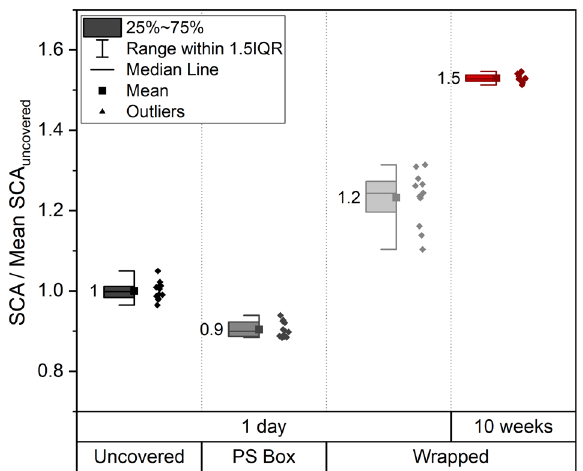
Figure 2. Contact angle of a 3 µl droplet on polished copper samples stored without any cover (uncovered), in a common polystyrene sample box (PS Box) or wrapped in a woodfree tissue (Wrapped). For the wrapped samples a storage time of one day is compared to 10 weeks of storage. The different sample packaging methods lead to different contact angles although all were stored under the same ambient atmospheric conditions. Per storage condition two samples were investigated by applying 6 droplets each. The reference data for normalization is “uncovered/1 day”. Here data normalization was not done sample wise but with the total mean value of the two samples stored for one day uncovered as separate samples had to be used for every storage condition.